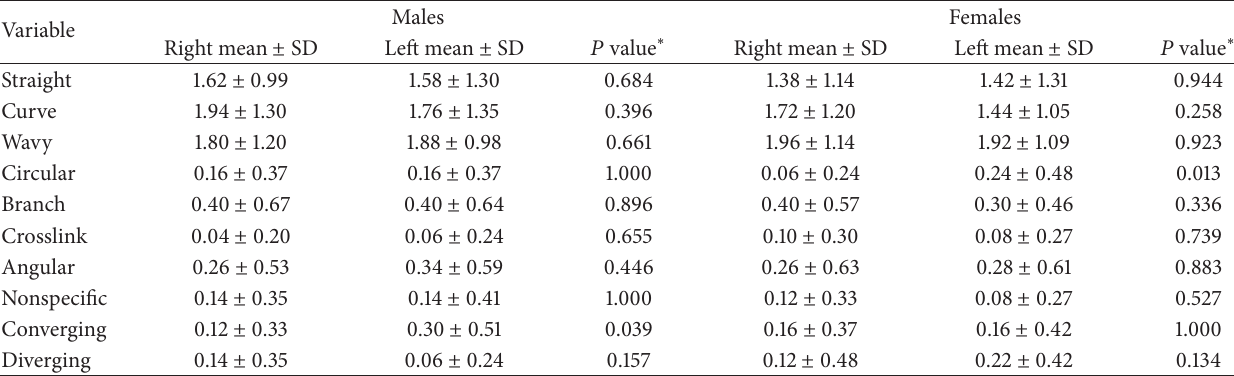
Table 5: Bilateral differences (left-right) in rugae shapes in both sexes.